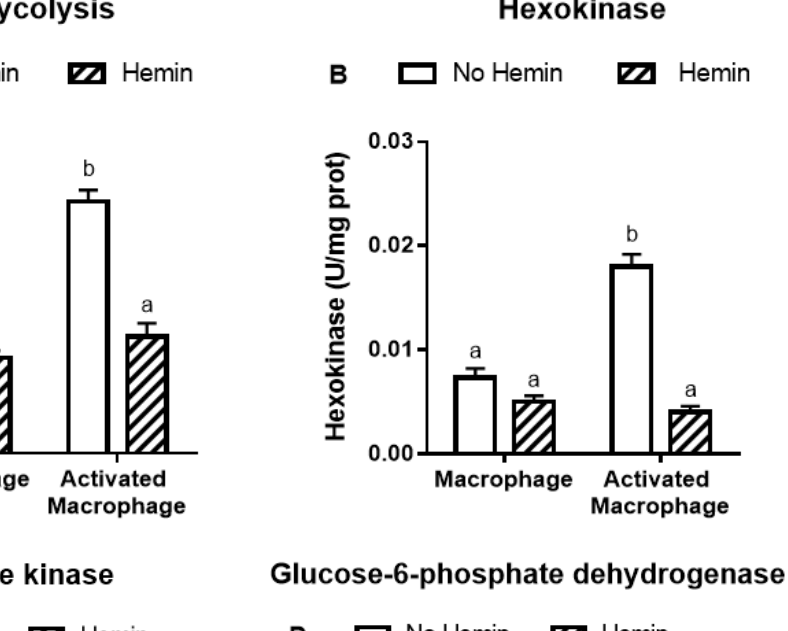
Figure 4. The increase of cytosolic HIF-1 α levels of activated macrophages is inhibited by hemin. ( A ) Nuclear and ( B ) cytosolic HIF-1 α levels and ( C ) representative images of macrophages and activated macrophages, in the absence or presence of 10 μ M hemin for 72 h. HIF-1 α levels were detected by immunofluorescence using a confocal imaging system (Opera Phenix, Perkin Elmer). Images were acquired with 20x water objective. Staining intensity levels in the nucleus and cytosolic region were obtained using Harmony software (Perkin Elmer). Nucleus and cytosol were identified through Hoechst (at 405 nm) and CellMask (at 655 nm) staining, respectively. Scale is shown as 100 μ m. White